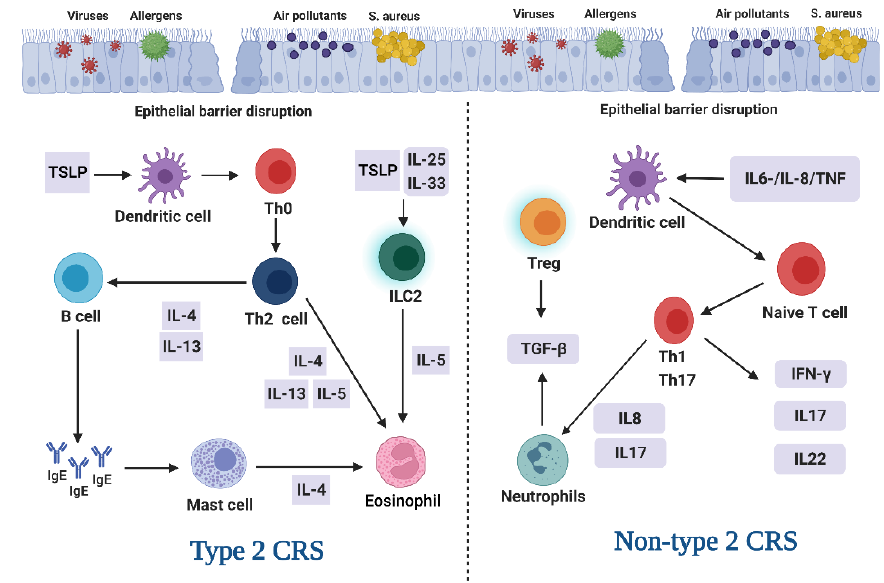
Figure 1. The type 2 and non-type 2 endotypes of